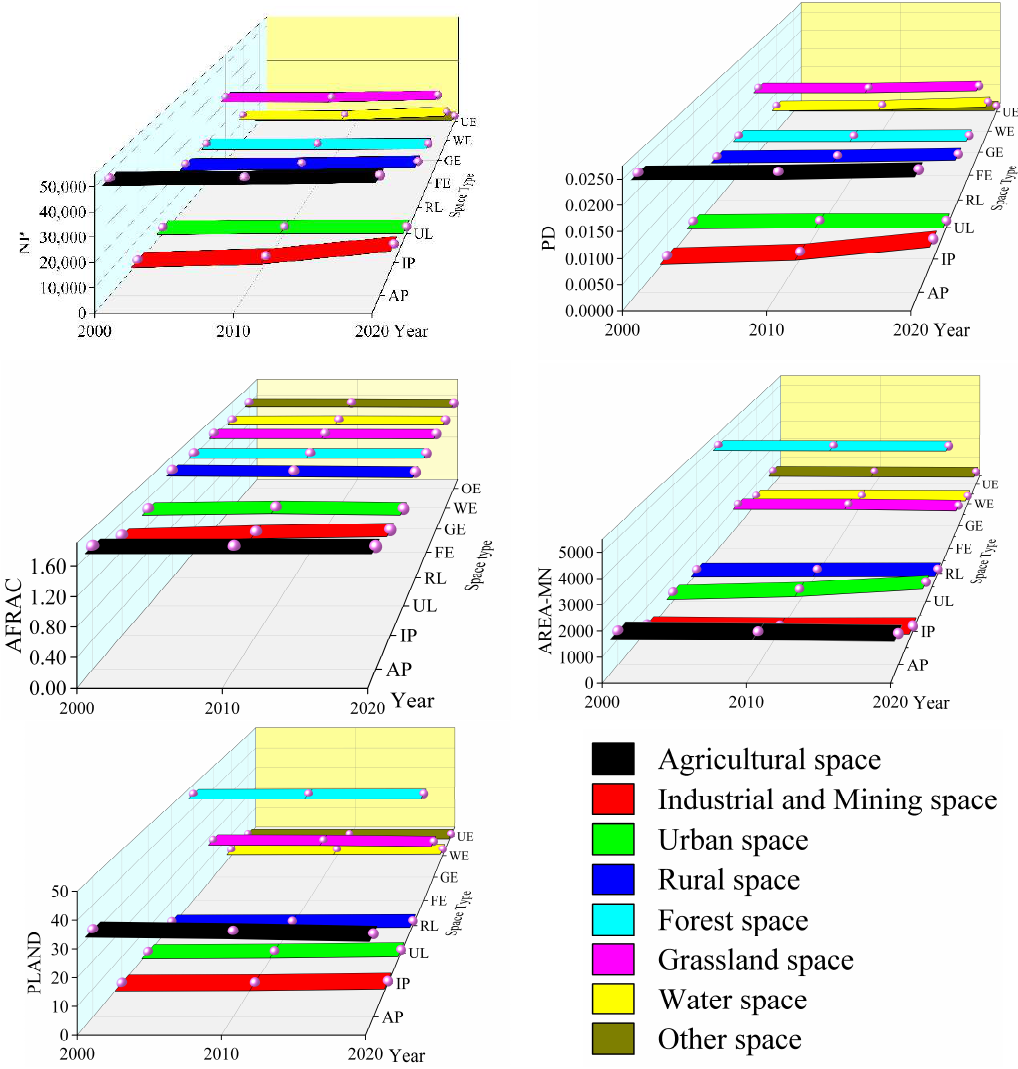
Figure 12. Changes in landscape pattern indices at the class level in the Yangtze River Economic Belt from 2000 to 2020.